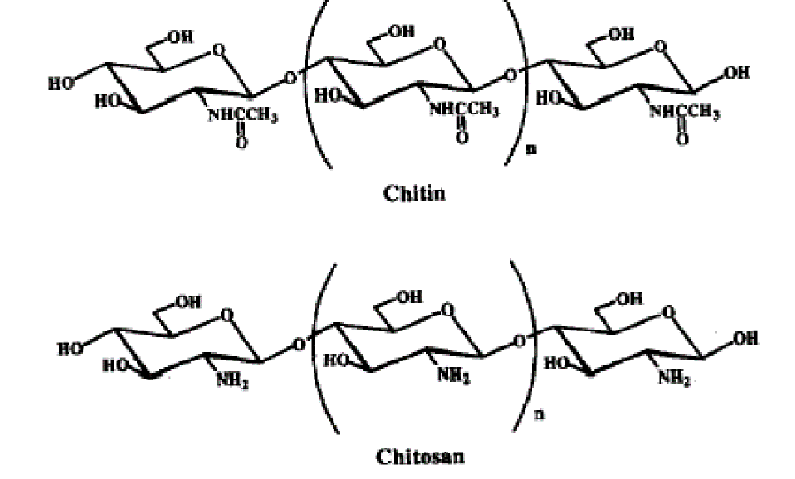
Fig. 1 Structure of chitin and chitosan.